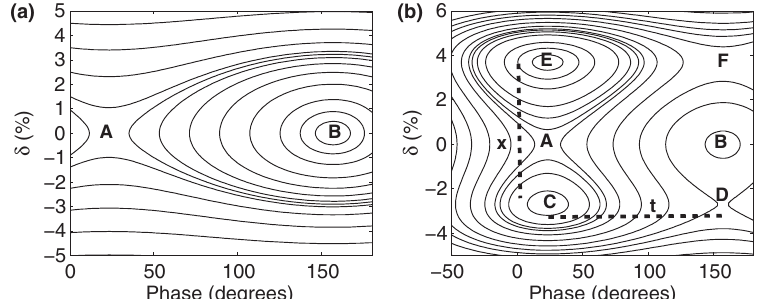
FIG. 5. Effect of the sign of (cid:1) 3 on the longitudinal phase space for the nominal SOLEIL optics with (cid:1) 1 ¼ 4 : 4 (cid:1) 10 (cid:2) 4 , (cid:1) 2 ¼ 0 : 39 in (a), (cid:1) 0 : 39 in (b), assuming the minimum value (cid:6) ¼ 4 : 3 (cid:1) 10 (cid:2) 9 . Three beams can be 4 : 5 (cid:1) 10 (cid:2) 3 , and the values (cid:1) 3 ¼ 3 ¼ (cid:2) stored in case (b) providing that the transverse dynamic and physical acceptances are large enough. The transverse distance x between off-momentum stable buckets is D x ð (cid:2) E Þ (cid:2) D ð (cid:2) C Þ while t is the time distance between buckets at the different phases. The letters A, D, F represent the unstable fixed points and B, C, and F, the stable fixed